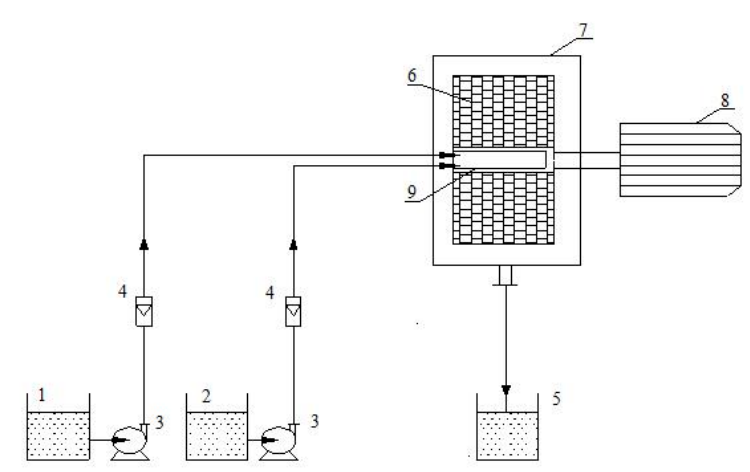
Figure 1. Schematic representation of HGAP process (1: drug solution tank; 2: anti-solvent tank; 3: pump; 4: flow meters; 5: tank; 6: packed rotator; 7: casing; 8: motor; 9: liquid distributor).